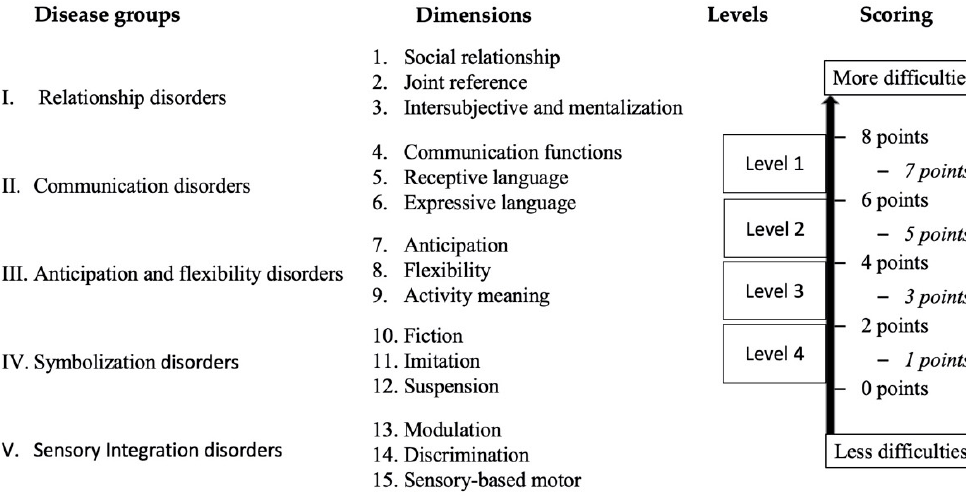
Figure 1. Summary of Rivière’s Autism Spectrum Inventory [60,61]. Disease groups from I–IV with their 12 dimensions correspond to Rivière’s original version. The V scale with the dimensions 13–15 was added by García-Gómez [62]. Preferred scores for rating the Inventory are the even ones, while odd scores are used to describe intermediate stages.